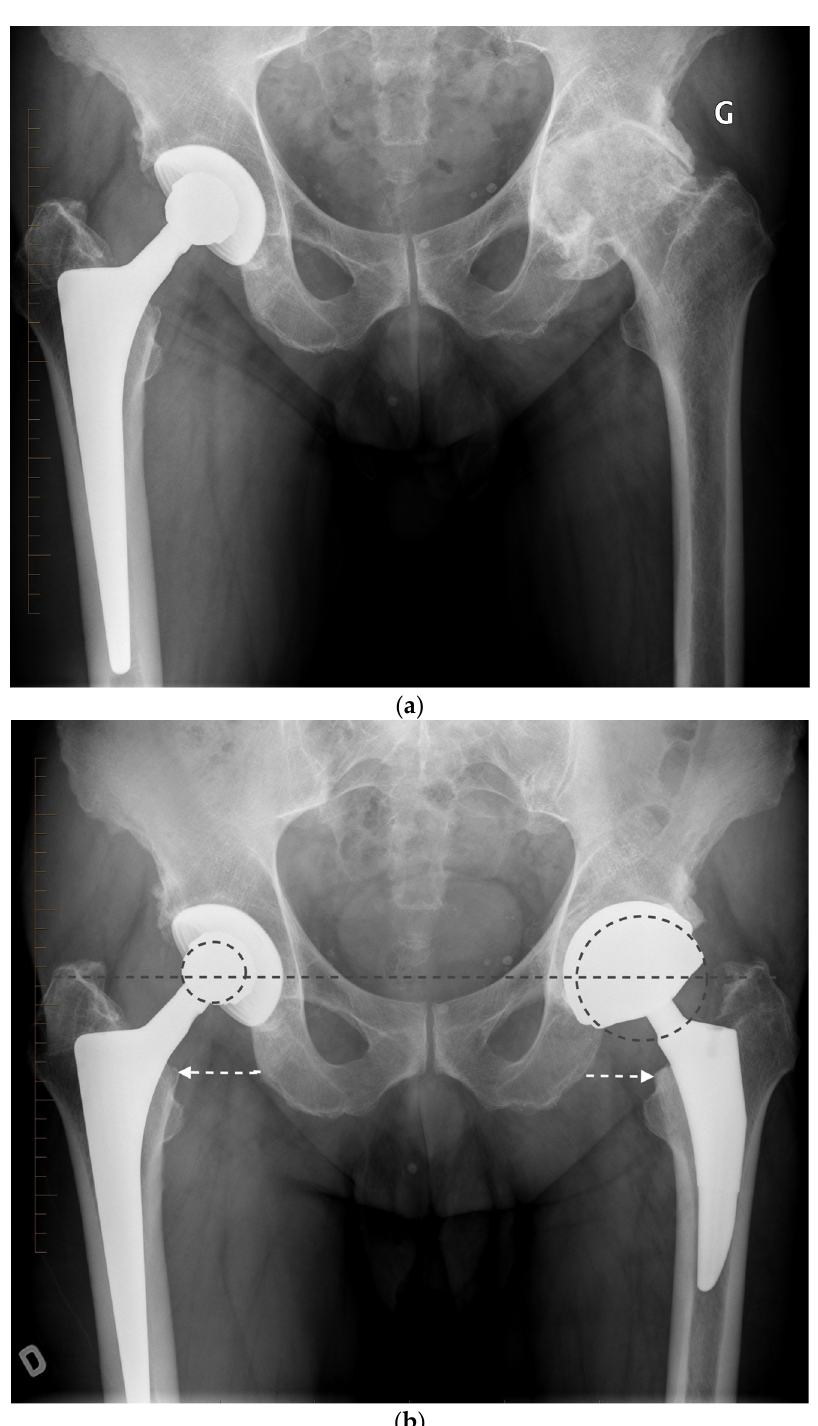
Figure 5. ( a ) Antero-posterior pelvis radiograph of a 55-year-old man with a right metal-on-metal 28 mm THA and severe osteoarthritis of the left hip. ( b ) Postoperative radiograph after a left LDH THA with leg length and femoral offset restoration.